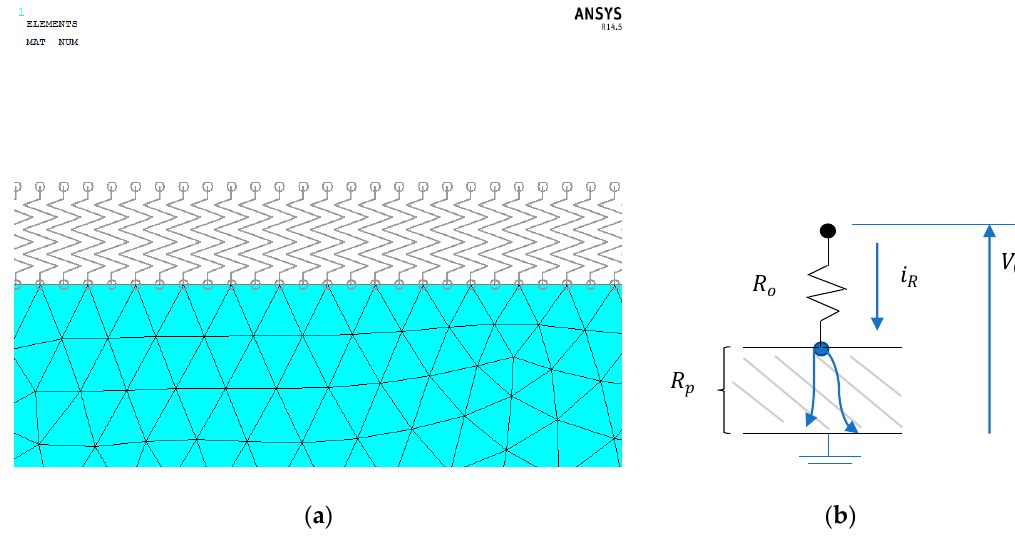
Figure 2. ( a ) Part of the FE mesh of the meso-scale model showing the connection of the circuit elements with the nodes of the nanocomposite and ( b ) sketch of the electric circuit of the meso-scale model.